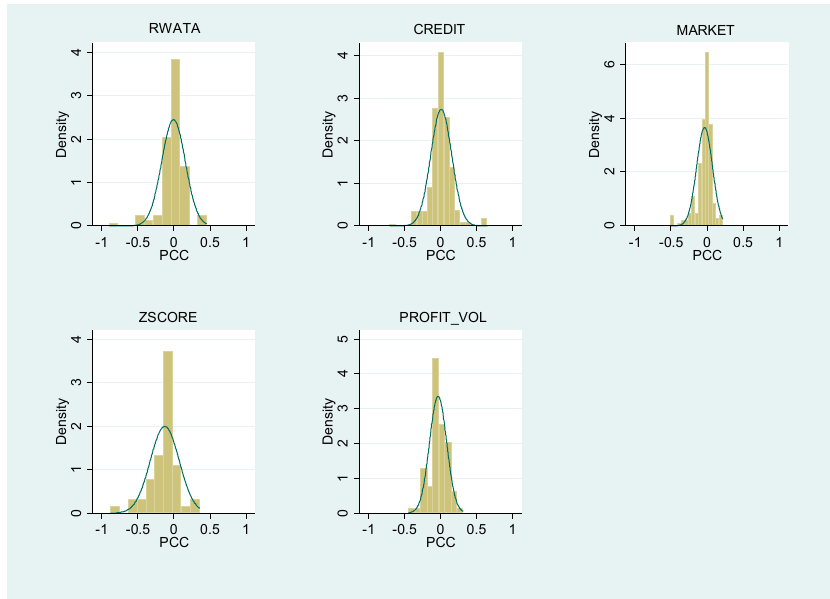
Figure 4. The PCC distribution by risk measurements.